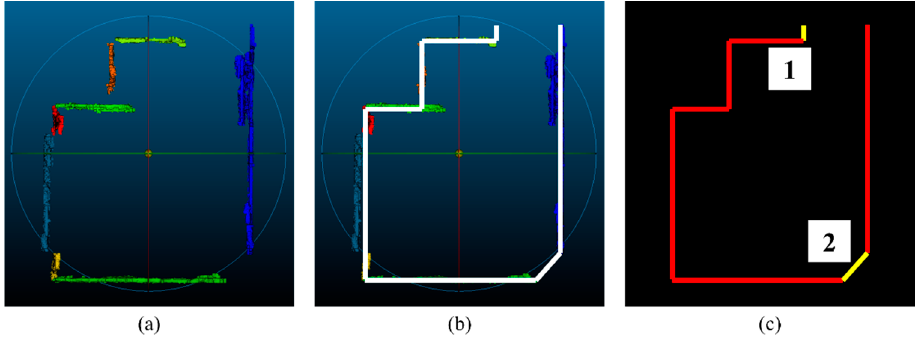
Figure 15. ( a ) Detected walls; ( b ) Comparison walls with floorplan; ( c ) Undetected